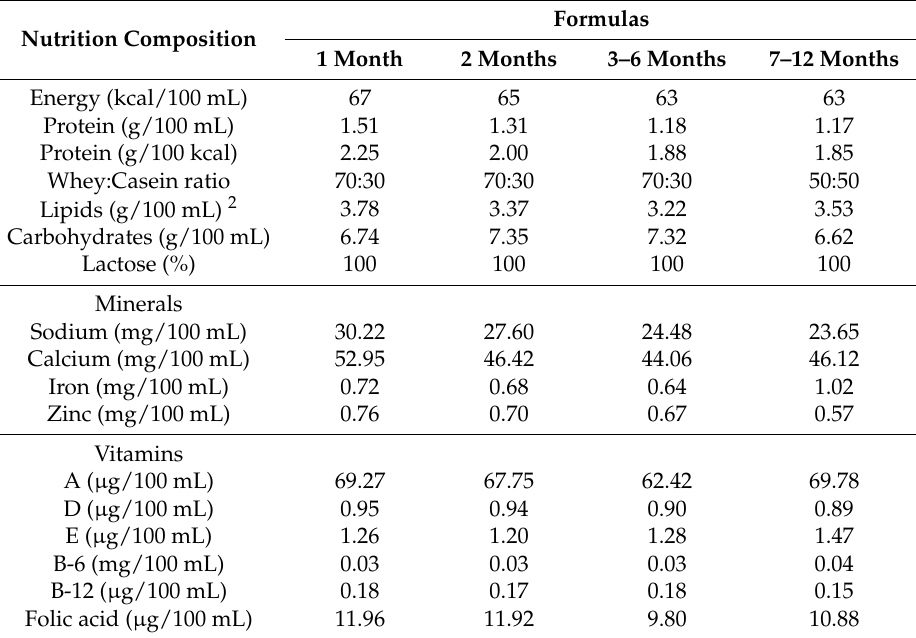
Table 1. Composition of study formulas 1